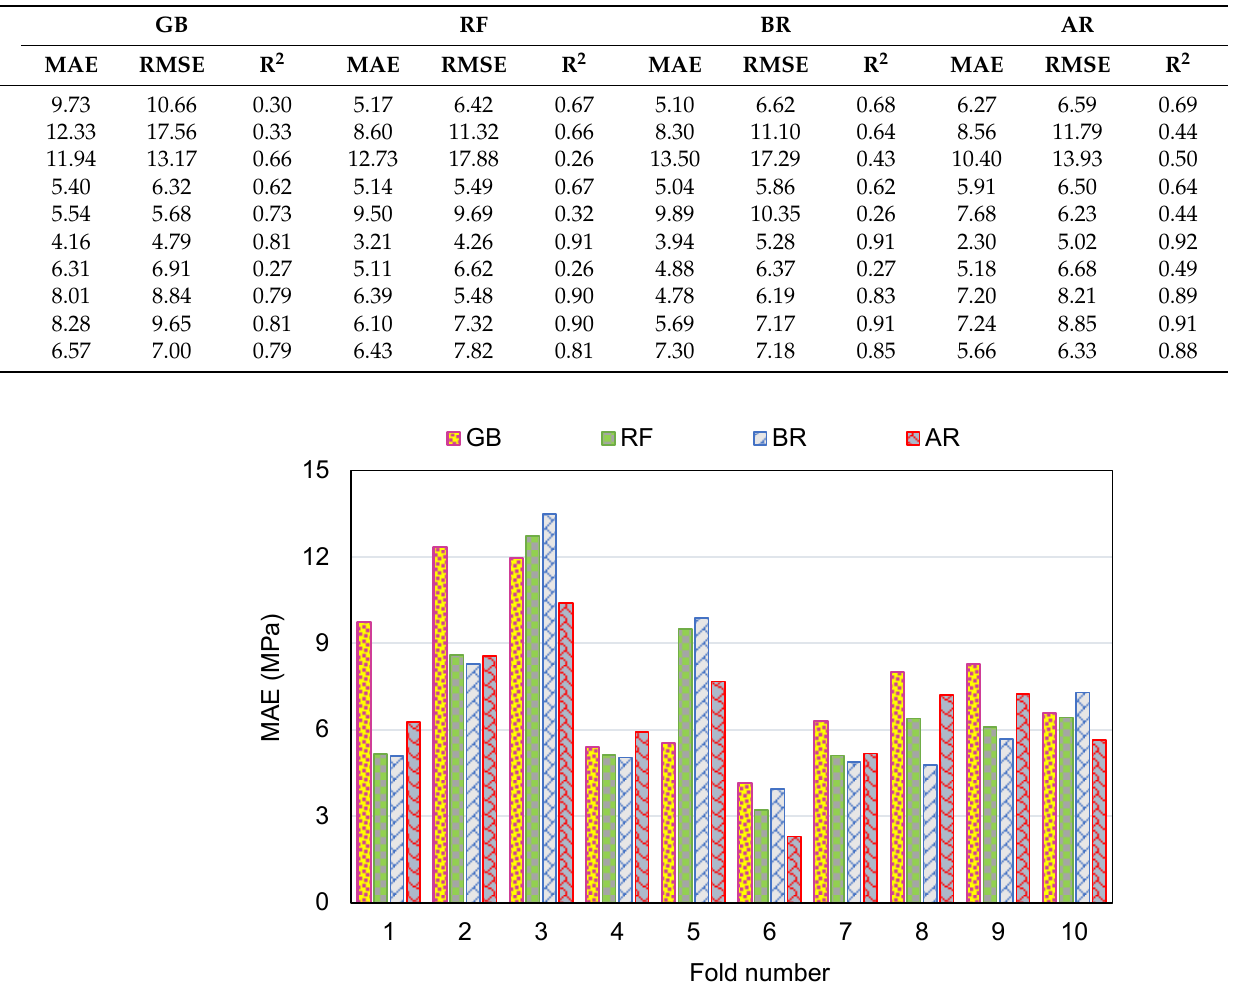
Figure 12. MAE dispersal from k-fold evaluation.